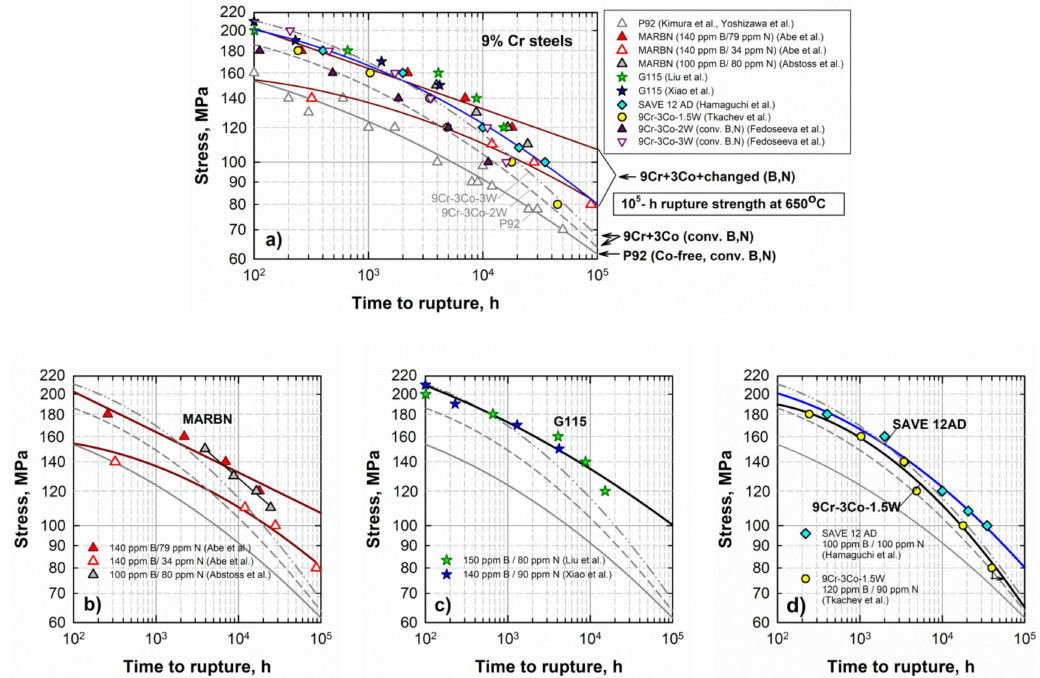
Figure 8. Time to rupture vs. stress curves of 9% Cr steels with increased B and decreased N contents in comparison with curves for 9% Cr steels with conventional B, N contents ( a – d ). Experimental data from